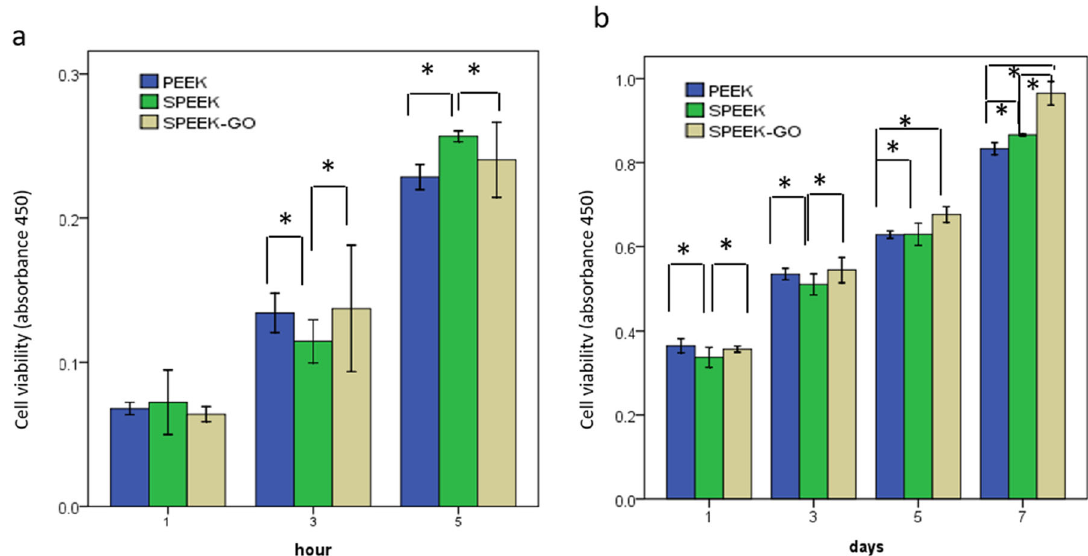
Fig. 12 a Adhesion of MC3T3-E1 at 1, 3, and 5 h, as detected using CCK-8 reagent. b Proliferation of MC3T3-E1 cells at 1, 3, 5, and 7 d, as detected using CCK-8